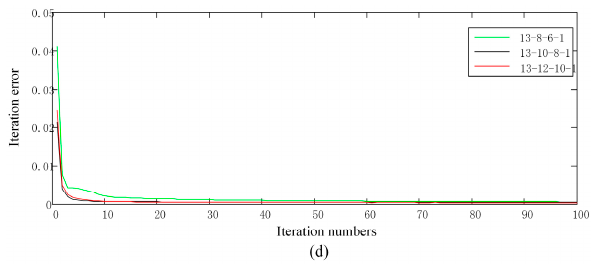
Figure 3. ( a – d ) The correlation of iteration numbers and iteration error. Figure 3. ( a – d )The correlation of iteration numbers and iteration error. Figure 3. ( a – d )The correlation of iteration numbers and iteration error.